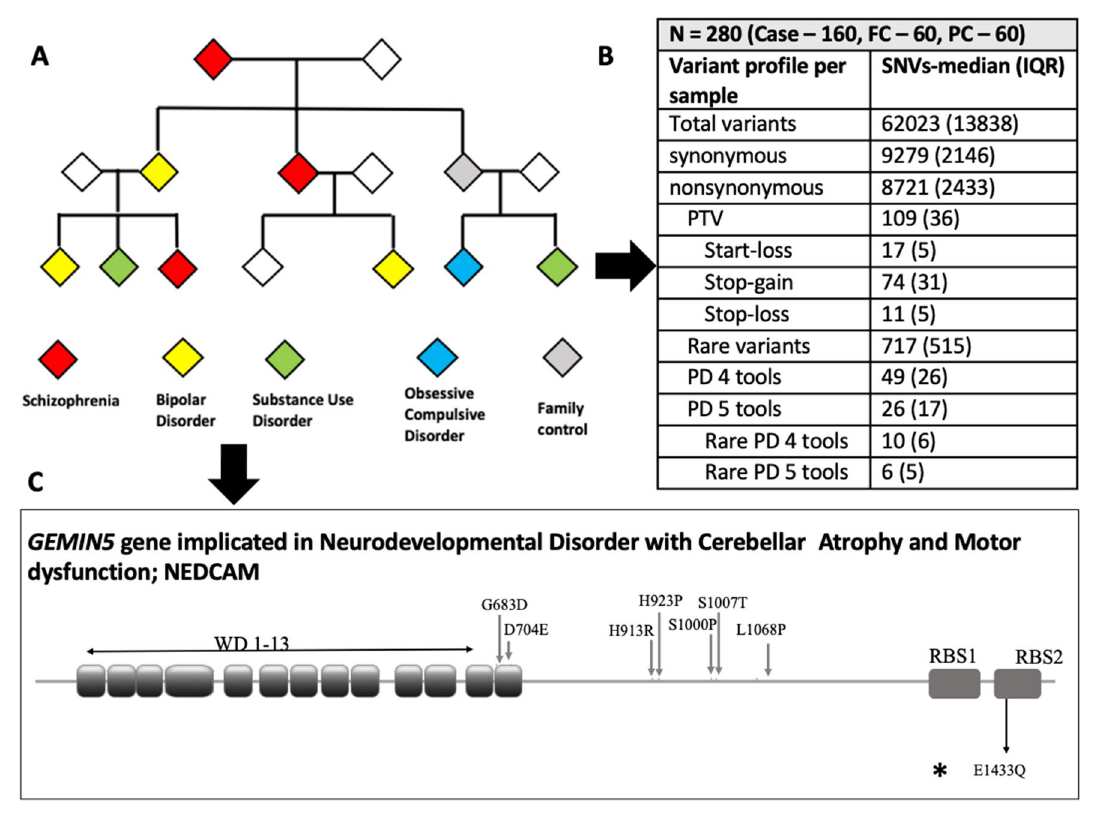
Figure 1. Conceptual overview—exome sequencing was done for individuals from families with multiple members with serious mental illness (SMI). The table shows the meaningful (significant) variants detected. Details of one representative gene (GEMIN5) are shown. The seven variants marked above have been implicated in Neurodevelopmental Disorder with Cerebellar Atrophy and Motor dysfunction: NEDCAM earlier. The variant marked below rs544452250 (5-154268943-C-G; E1433Q) was predicted to be deleterious, and was shared across three individuals with schizophrenia, BPAD and Substance use disorder, in one